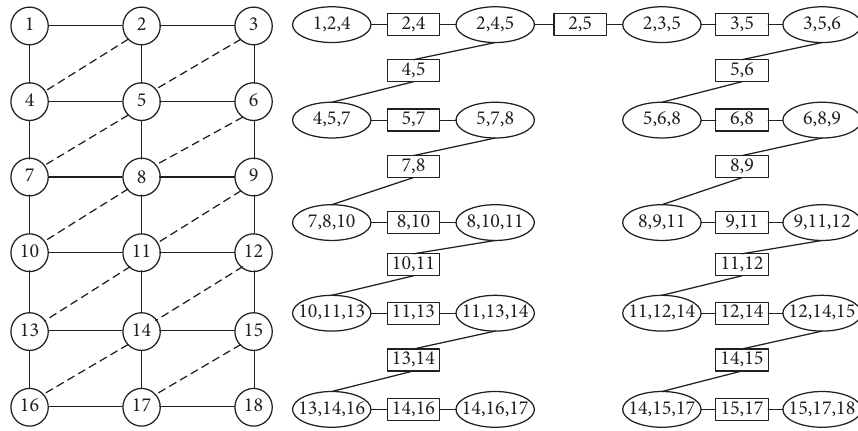
Figure 6: Triangulation and junction-tree construction of the test